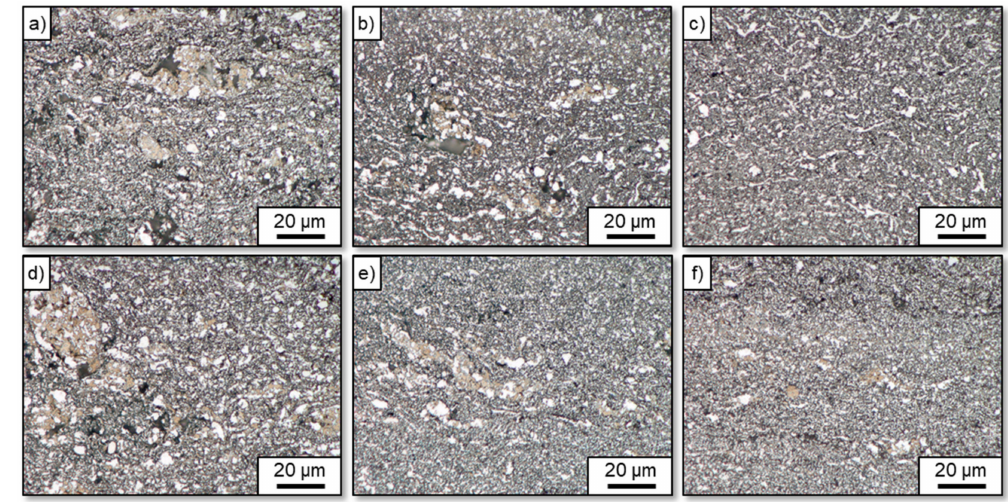
Figure 3. Etched cross-section images showing the coating microstructure with the use of di ff erent PGT and ST: ( a ) PGT: 300 ◦ C, ST: 20 ◦ C; ( b ) PGT: 350 ◦ C, ST: 20 ◦ C; ( c ) PGT: 400 ◦ C, ST: 20 ◦ C; ( d ) PGT: 300 ◦ C, ST: 260 ◦ C; ( e ) PGT: 350 ◦ C, ST: 260 ◦ C; and ( f ) PGT: 400 ◦ C, ST: 260 ◦